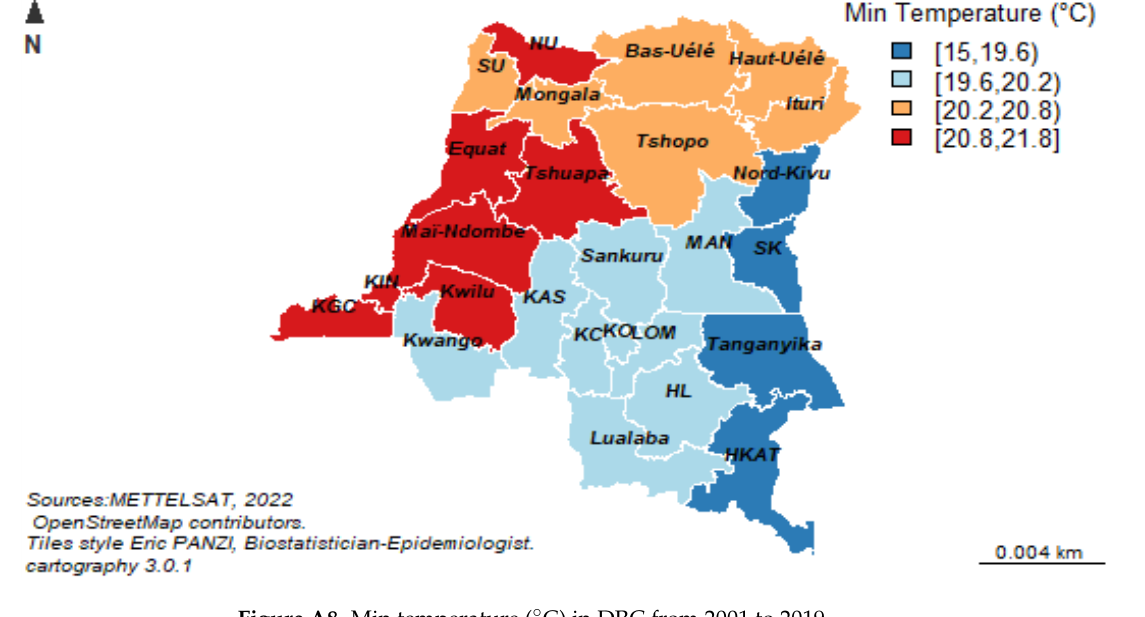
Figure A8. Min temperature (°C) in DRC from 2001 to 2019.